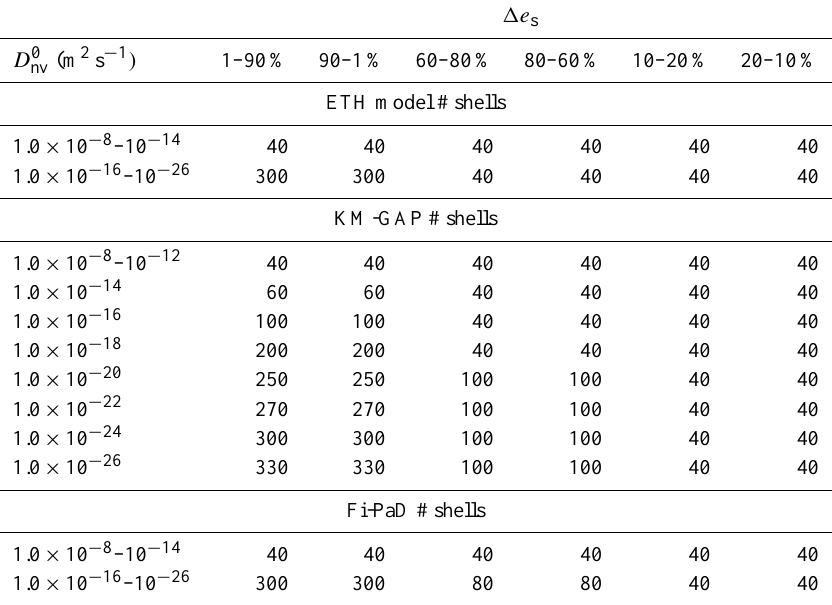
Table A2. Number of shells used in each model for each change in the vapour-phase saturation ratio of the semi-volatile component ( (cid:49)e s ) and for different values of non-volatile component self-diffusion coefficient ( D 0 nv )